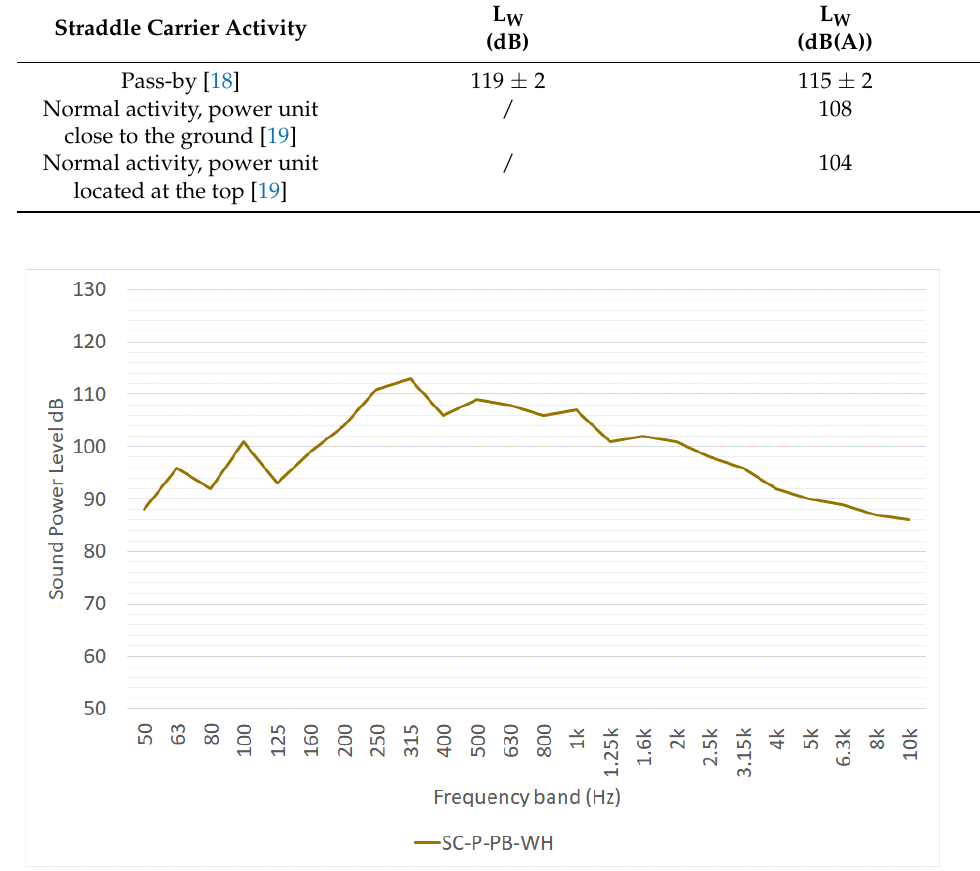
Figure 4. One-third octave sound power level spectrum of a straddle carrier pass-by, as reported in [17]. L W is expressed in dB/m for linear sources.